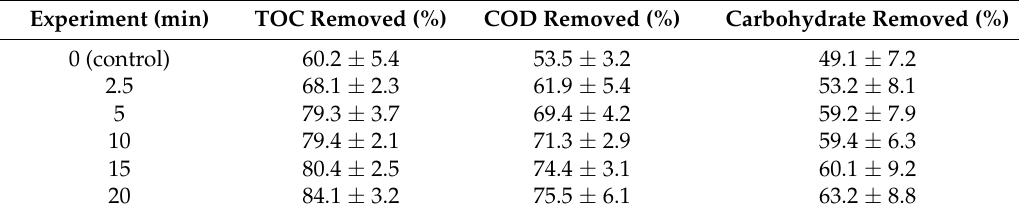
The percentages of total organic content (TOC), chemical oxygen demand (COD), and carbohydrate